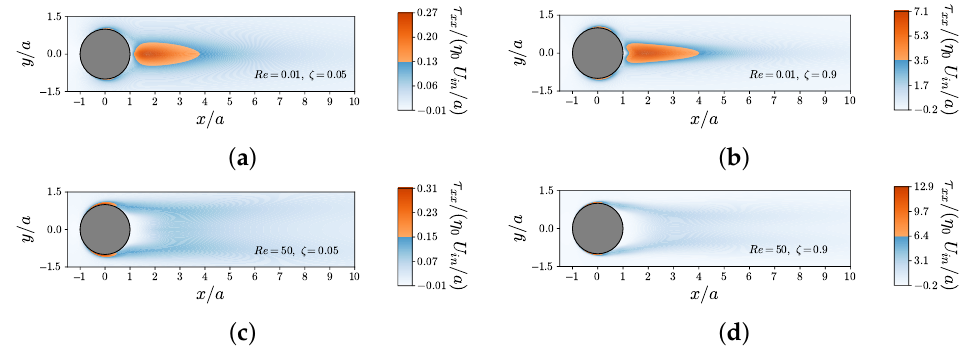
Figure 7. Contours of the dimensionless normal component of the polymeric extra-stress tensor τ xx for the shear thinning Giesekus viscoelastic fluid at fixed Wi = 5, α = 0.1 and different values of Re and ζ : ( a ) Re = 0.01 and ζ = 0.05, ( b ) Re = 0.01 and ζ = 0.9, ( c ) Re = 50 and ζ = 0.05, and ( d ) Re = 50 and ζ =